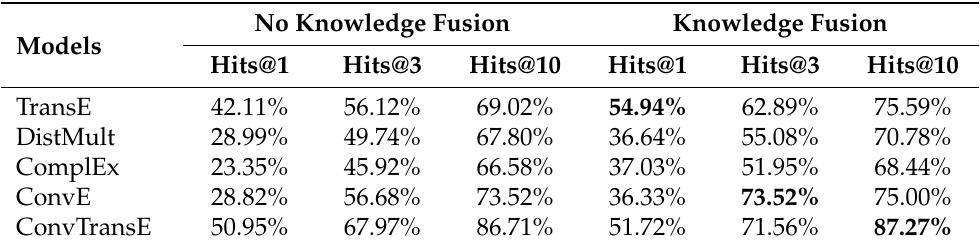
Table 2. The drug repurposing results of five knowledge graph completion models.